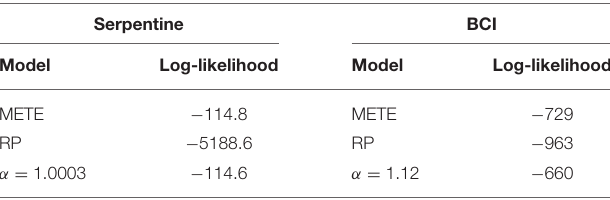
TABLE 1 | Log-likelihood values for the three different models, with α as a community parameter. Serpentine BCI Model